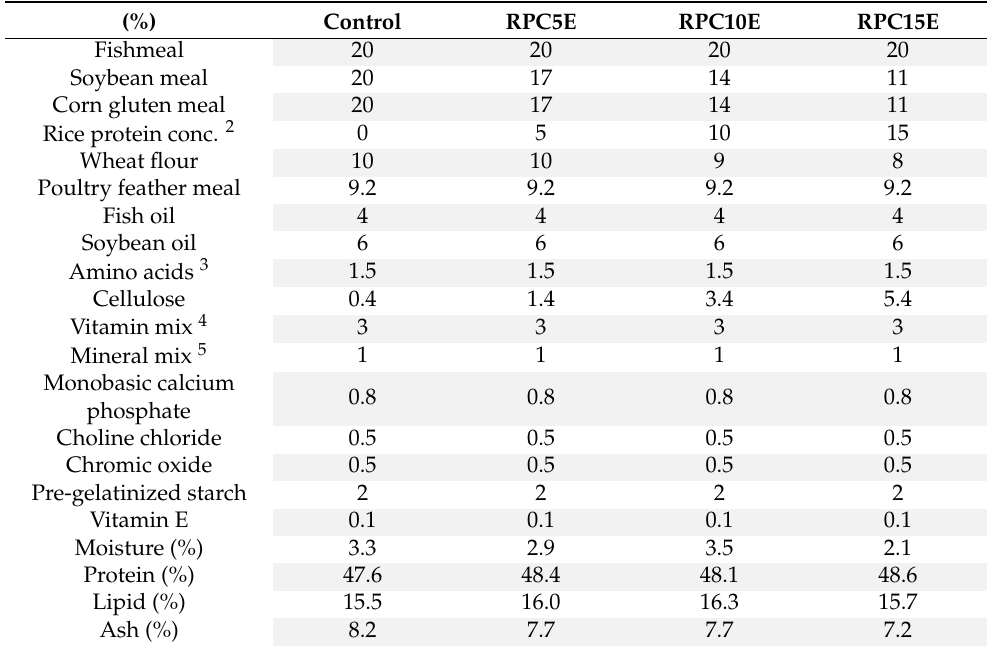
Table 2. Formula and analyzed proximate composition of the experimental diets 1